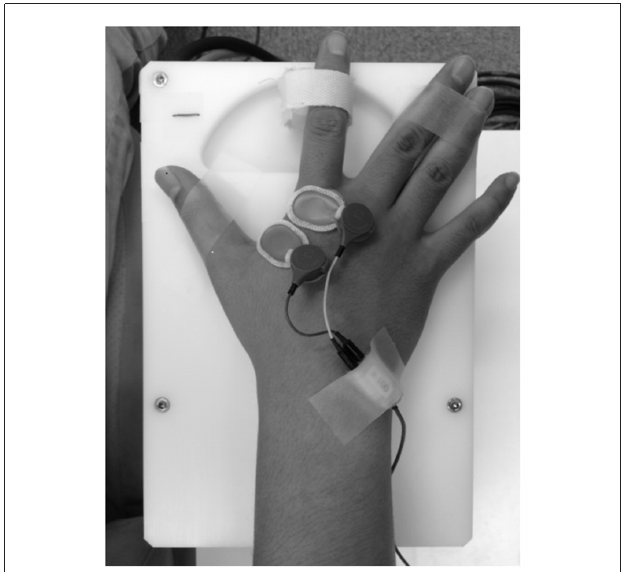
FIGURE 2 | Passive movement machine. This machine enables arbitrary setting of range of movement, movement velocity and pause time during passive movement of the index finger. It can also output external triggers at arbitrary joint angles during passive movement.